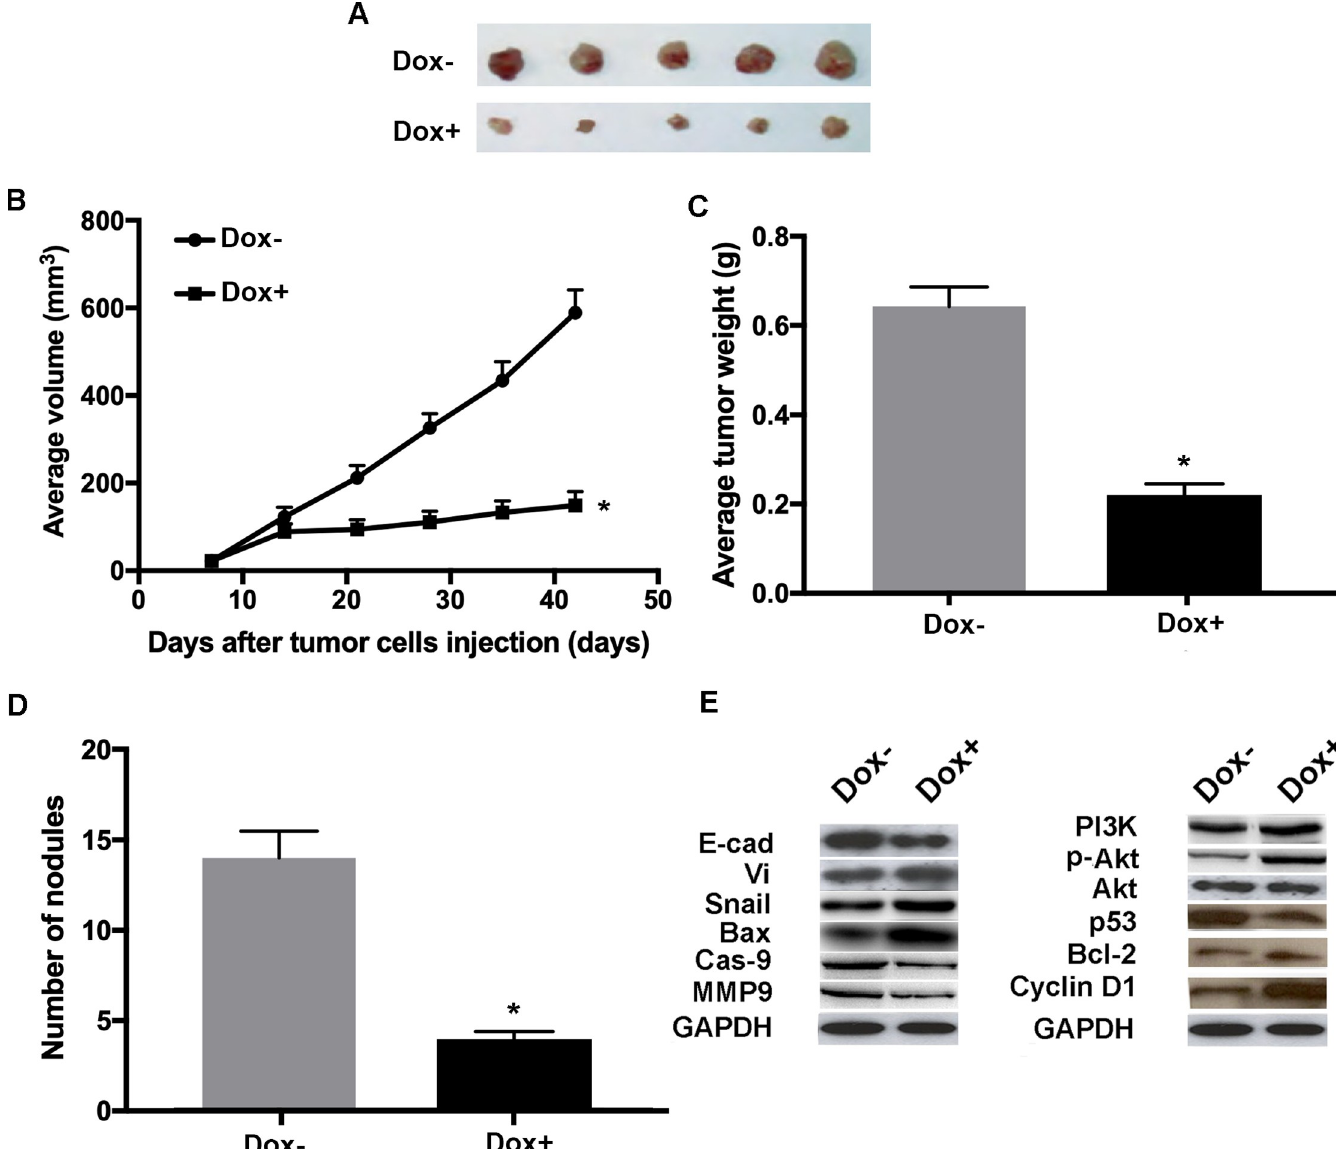
Fig 8. Doxycycline-induced expression of hsa_circRNA_100269 suppress the growth of GC in vivo . (A) The tumours in mice were harvested six weeks post- injection. (B) The average tumor volumes were examined in dox-induced group compared with the control. (C) Orthotopic tumor weights at day 42 post-injection were determined. (D) The numbers of nodules in mice were also calculated six weeks post-injection. (E) Protein levels of EMT, apoptosis and PI3K/Akt-associated molecules in xenograft tumors were evaluated by western blot analysis. A total of five mice were included in each experimental group. All the experiments were performed in triplicate. � P < 0.05 vs. corresponding control group. n = 5 per each group. GC, gastric